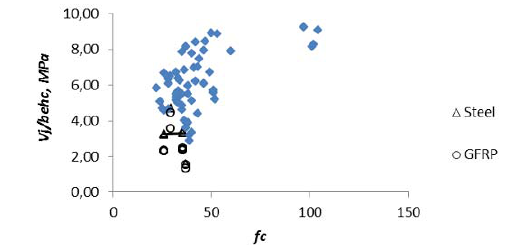
Figure 17. Influence of joint stirrups.